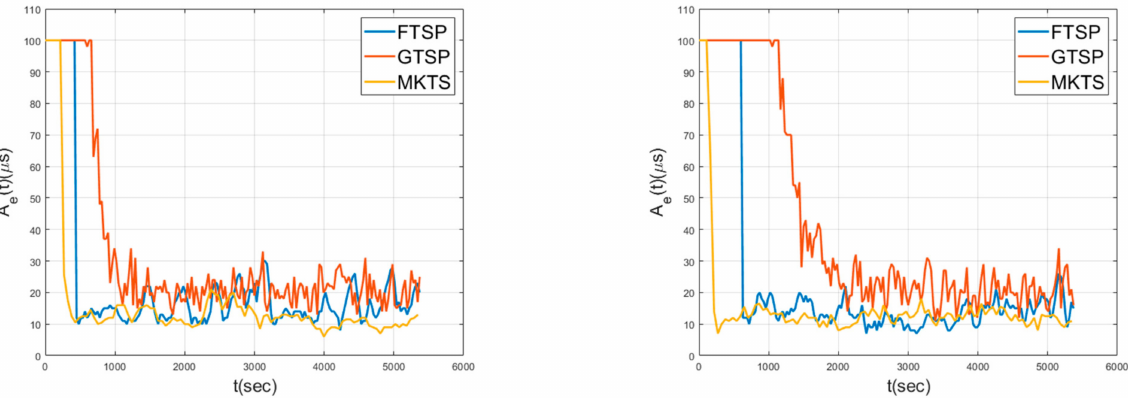
Figure 7. Network error in static environment for mesh (left) and random (right)